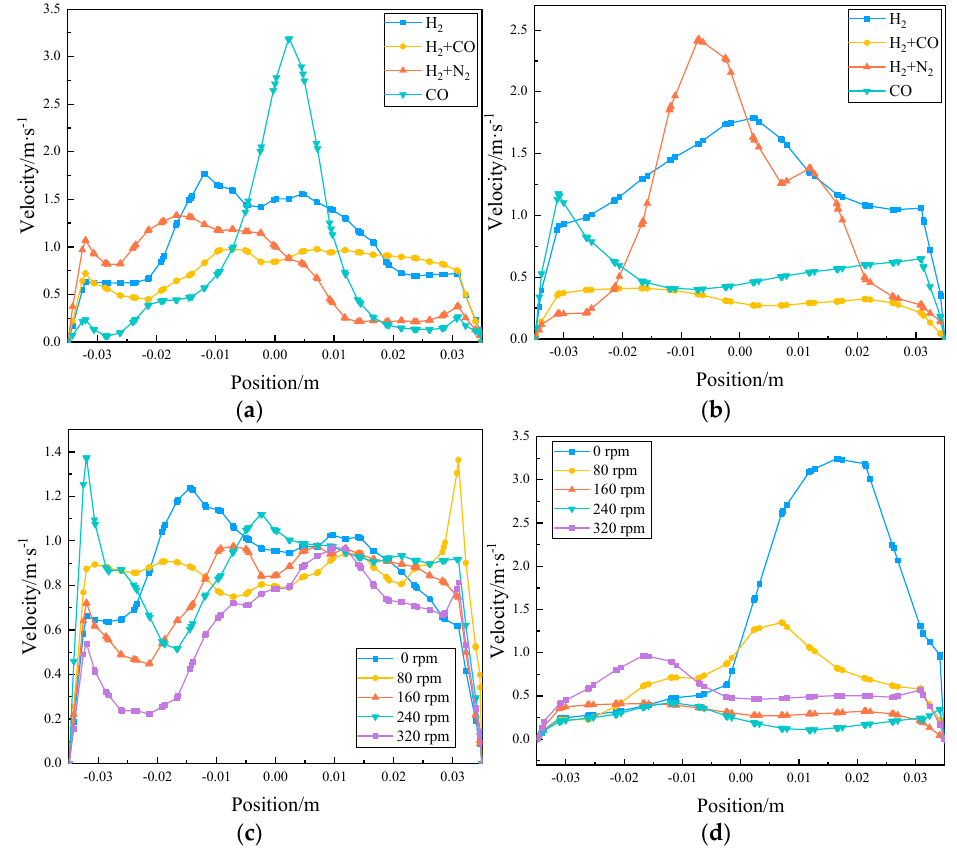
Figure 9. Radial gas velocity distribution at heights 0.07 and 0.21 m. ( a ) Different gas compositions at 0.07 m; ( b ) Different gas compositions at 0.21 m; ( c ) Different agitation speeds at 0.07 m; ( d ) Different agitation speeds at 0.21m.